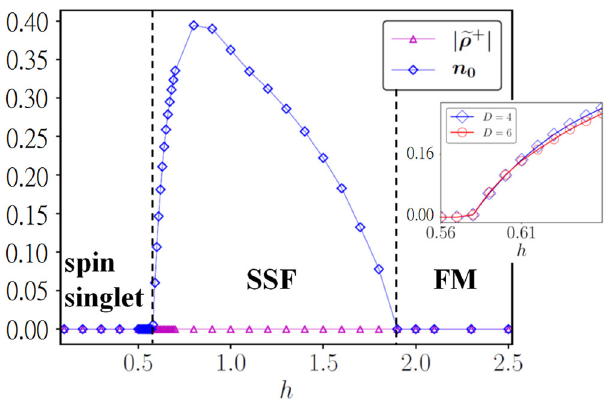
Fig. 2 Field-induced Bose-Einstein condensation for H KN with θ = 0.4 π . h stands for the strength of fi eld while SSF and FM represent the spin super fl uid and ferromagnetic phases distinctly. j ~ ρ þ j and n 0 come from the de fi nition in Eqs. (7) and (8). The small inset demonstrates n 0 for bond dimension D = 4 and D = 6 (dimension for environment tensors χ = 36) separately near the transition point from spin singlet to SSF. We can see that the transition point is located at around h = 0.58 from both bond dimensions.